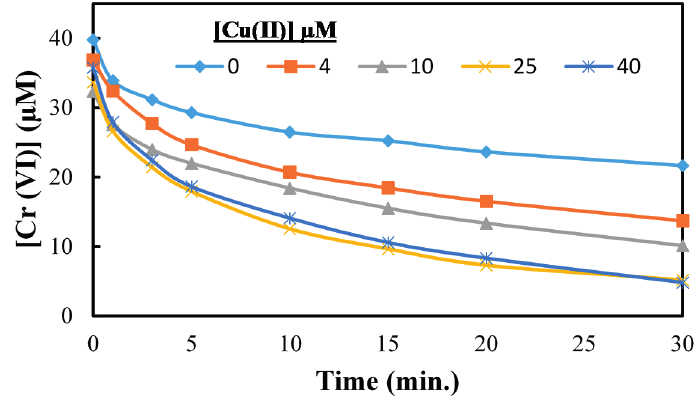
Figure 8. The effect of different Cu(II) concentration on Cr(VI) reduction in presence of As(V). [Cr(VI)] = 40 µM, [As(V)] = 25 µM, [Cu(II)] = 0–40 µM, pH = 3, [TiO 2 ] = 0.10 g/L, 350